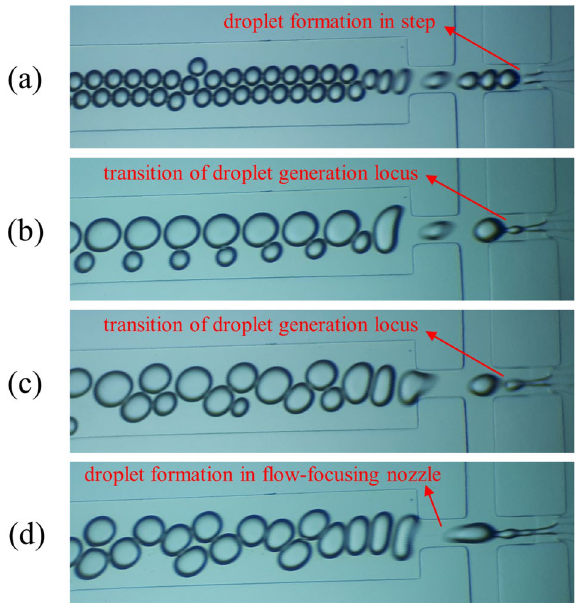
Figure 2. Transition of droplet generation locus (from step ( a ) to flow focusing nozzle ( d )) with increasing Q a and Q s at a constant ratio (α = 1) and a specific value of Q c (Q c = 30 μL/min). ( a ) Q a = 18 μL/min. ( b ) Q a = 24 μL/ min. (c) Q a = 30 μL/min. (d) Q a = 36